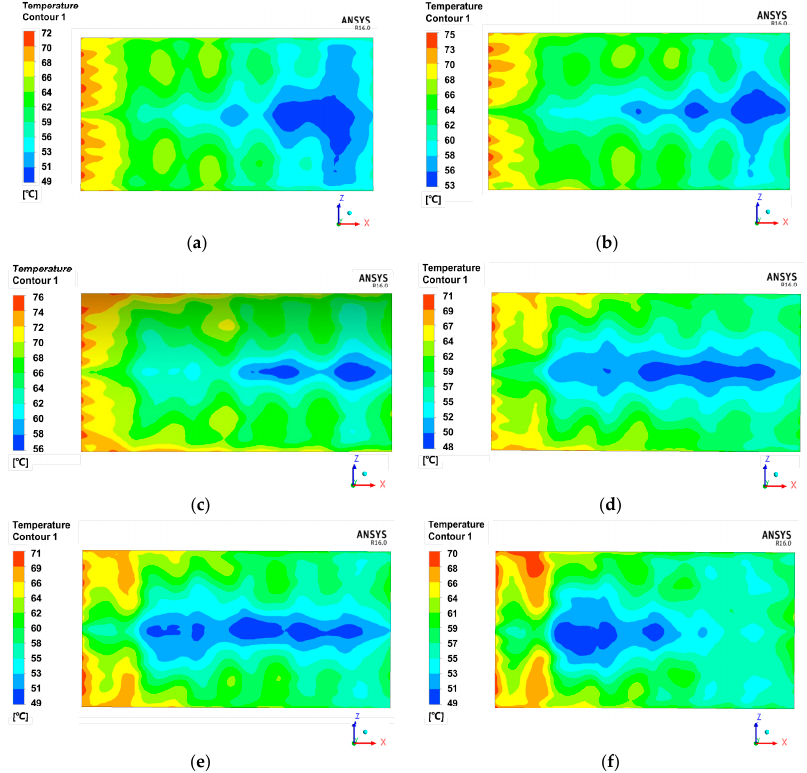
Figure 14. Temperature distribution contours of different angles. ( a ) α =175°, ( b ) α =170°, ( c ) α =168°, ( d ) β =5°, ( e ) β =10°, ( f ) β =12°.